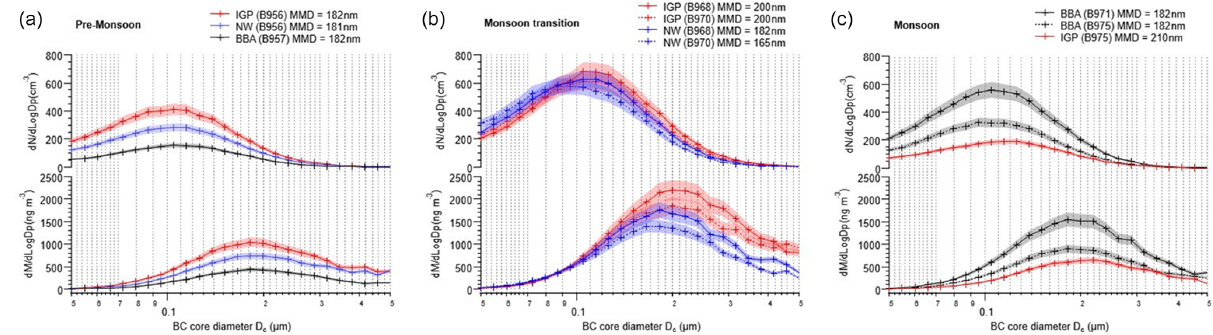
Figure 8. BC core diameter ( D c ) size distributions classified by (a) pre-monsoon, (b) monsoon transition, and (c) monsoon season. The shading is the square root (%) errors for each distribution. Orange represents the IGP, with blue representing NW India (JAI–JOD) and black NE India (BBA).